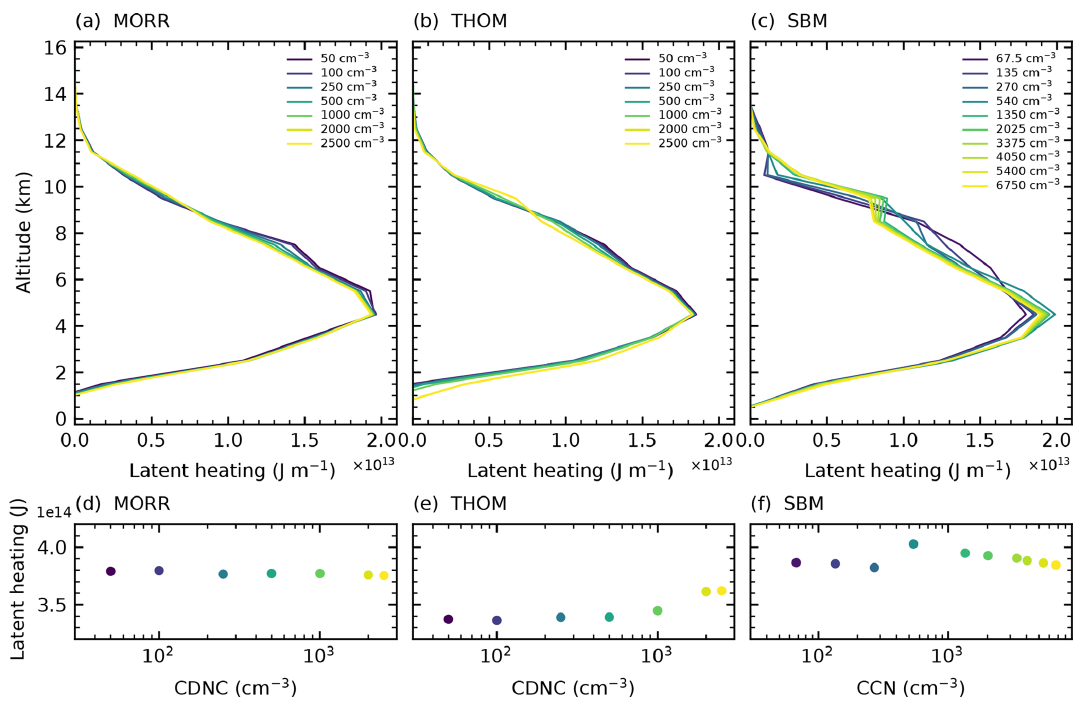
Figure 10. Profiles of the sum of latent heating over the lifetime of the dominant tracked cell for the three microphysics schemes in CASE1.